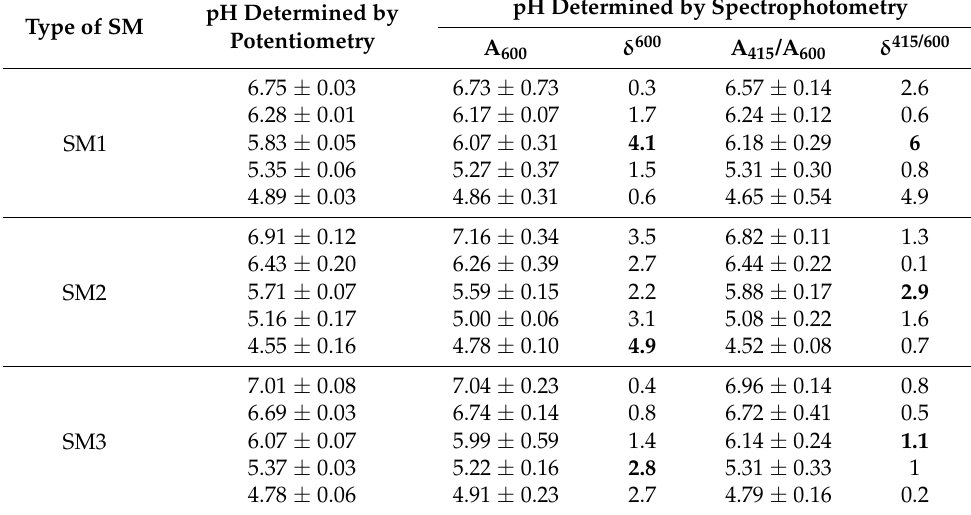
Table 3. Validation of the pH obtained in milk by spectrophotometry with the pH from potentiometry ( n =